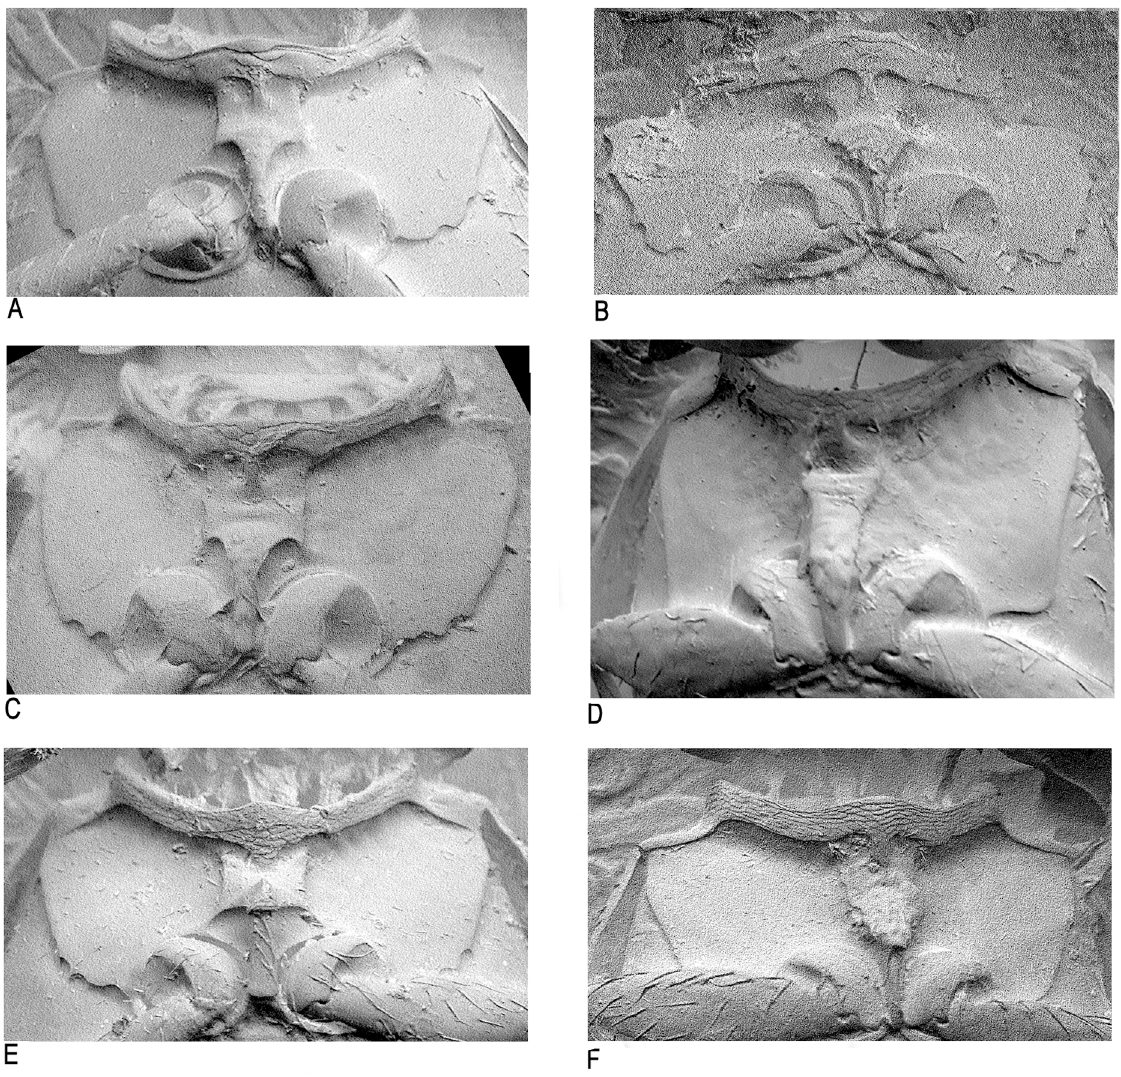
Fig. 8. Cissidium spp., mesoventra. A . C. globulum sp. nov. ×470. B . C. pauxillum sp. nov ×725. C . C. marshallae sp. nov ×335. D . C. longum sp. nov. ×450. E . C. subfoveolatum sp. nov. ×455. F . C. triangulum sp. nov.